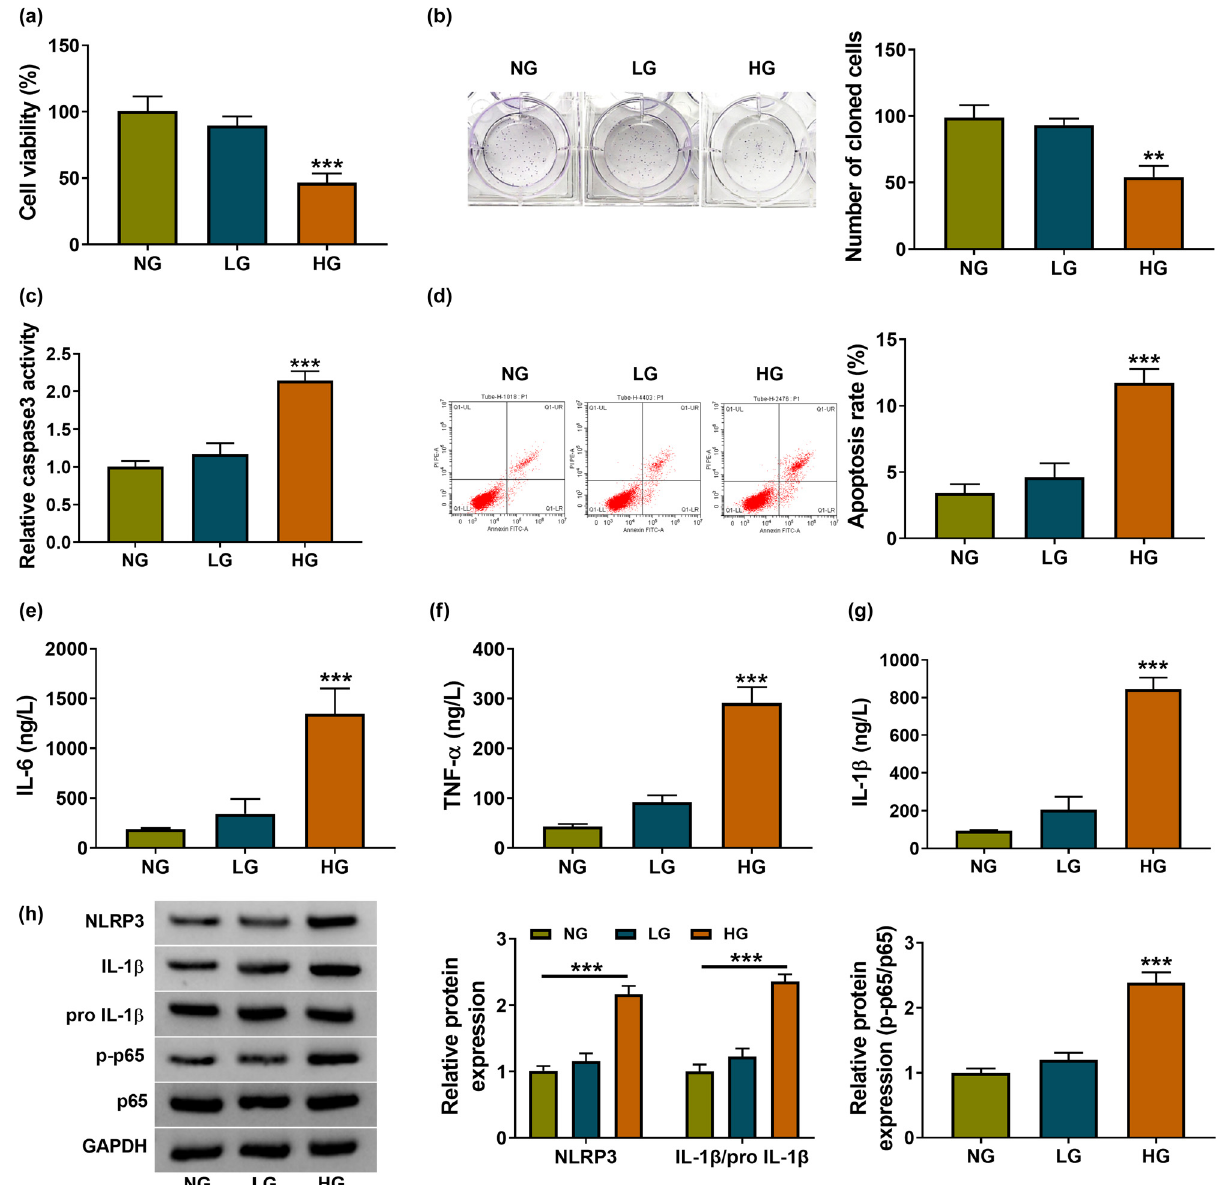
Figure 1: HG blocked HK - 2 cell growth while induced apoptosis promotion, in fl ammatory response, and NF - κ B activation. HK - 2 cells were treated with NG, LG, or HG for 48h. ( a and b ) Cell viability ( a ) and colonizing capacity ( b ) were severally measured by CCK - 8 and colony formation assay. ( c and d ) Cell apoptosis was evaluated using caspase - 3 activity ( c ) and apoptosis rate ( d ) . ( e – g ) ELISA was used to determine the levels of IL - 6, TNF - α , and IL - 1 β . ( h ) NLRP3, IL - 1 β /pro - IL - 1 β , and p - p65/p65 protein levels were assayed via western blot. ** P < 0.01, *** P <